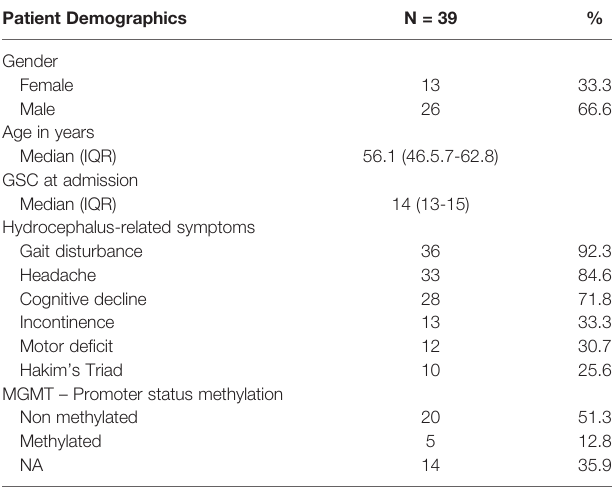
TABLE 1 | Patient ’ s demographics and admission